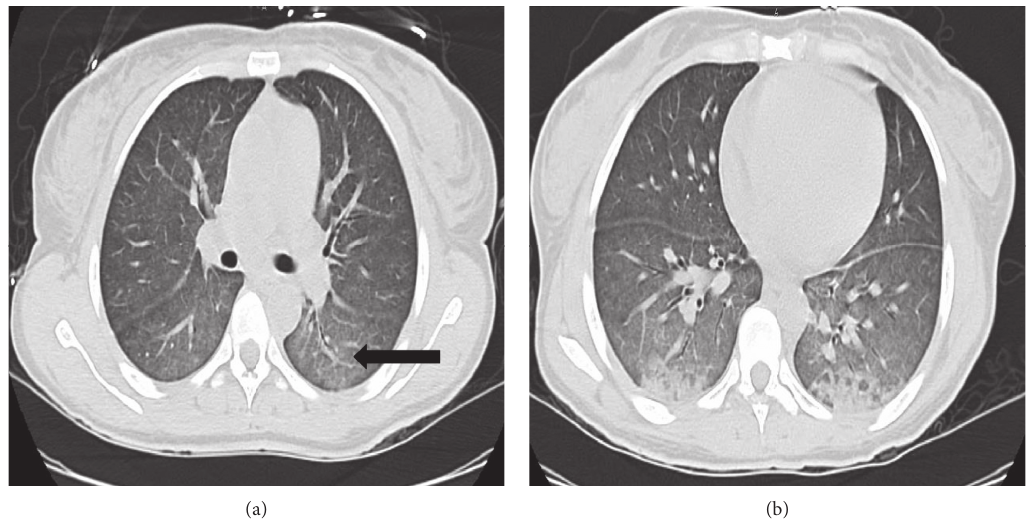
Figure 2: (a, b) CT scan of the chest showed lower lobe predominant confluent ground-glass opacities (arrow).